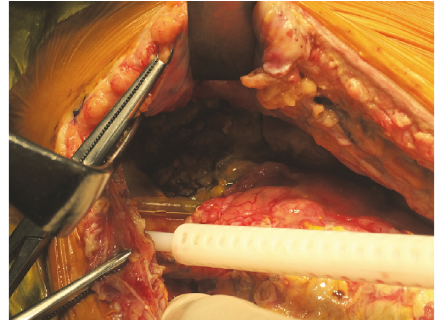
Figure 2: Postoperative day 15. Perforation of donor duodenum appeared to be due to the tip of the intestinal tube penetrating the